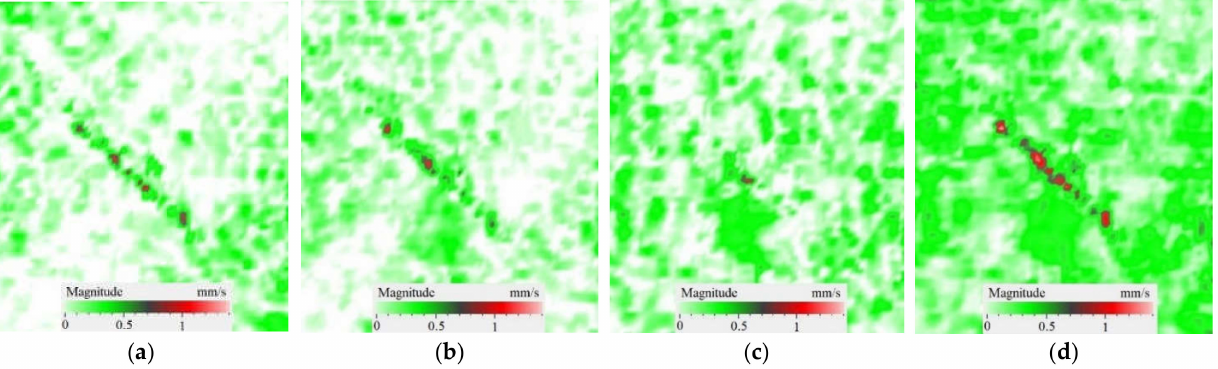
Figure 9. Resonance vibrations in CFRP composite with 18 J impact damage by x ( a ), y ( b ) and z coordinate ( c ) and total pattern at frequency of 43.6 kHz ( d